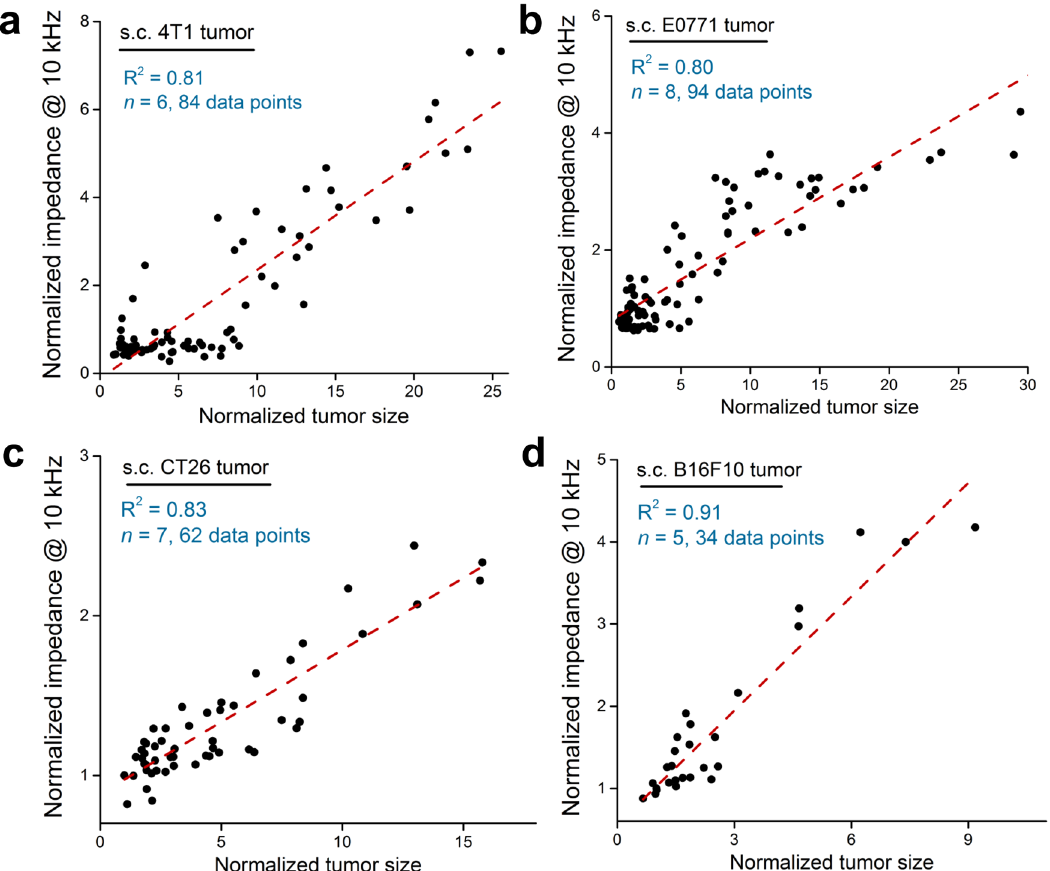
Fig. 2 In vivo tumor impedance measurements using IMOD. The linear regression relationships (red dashed lines) between normalized tumor size and normalized impedance at 10 kHz observed for subcutaneous a 4T1, b E0771, c CT26, and d B16F10 tumors. Normalized value is calculated based on the starting value of the measurement (set as 1 for both size and impedance readings at 10 kHz).